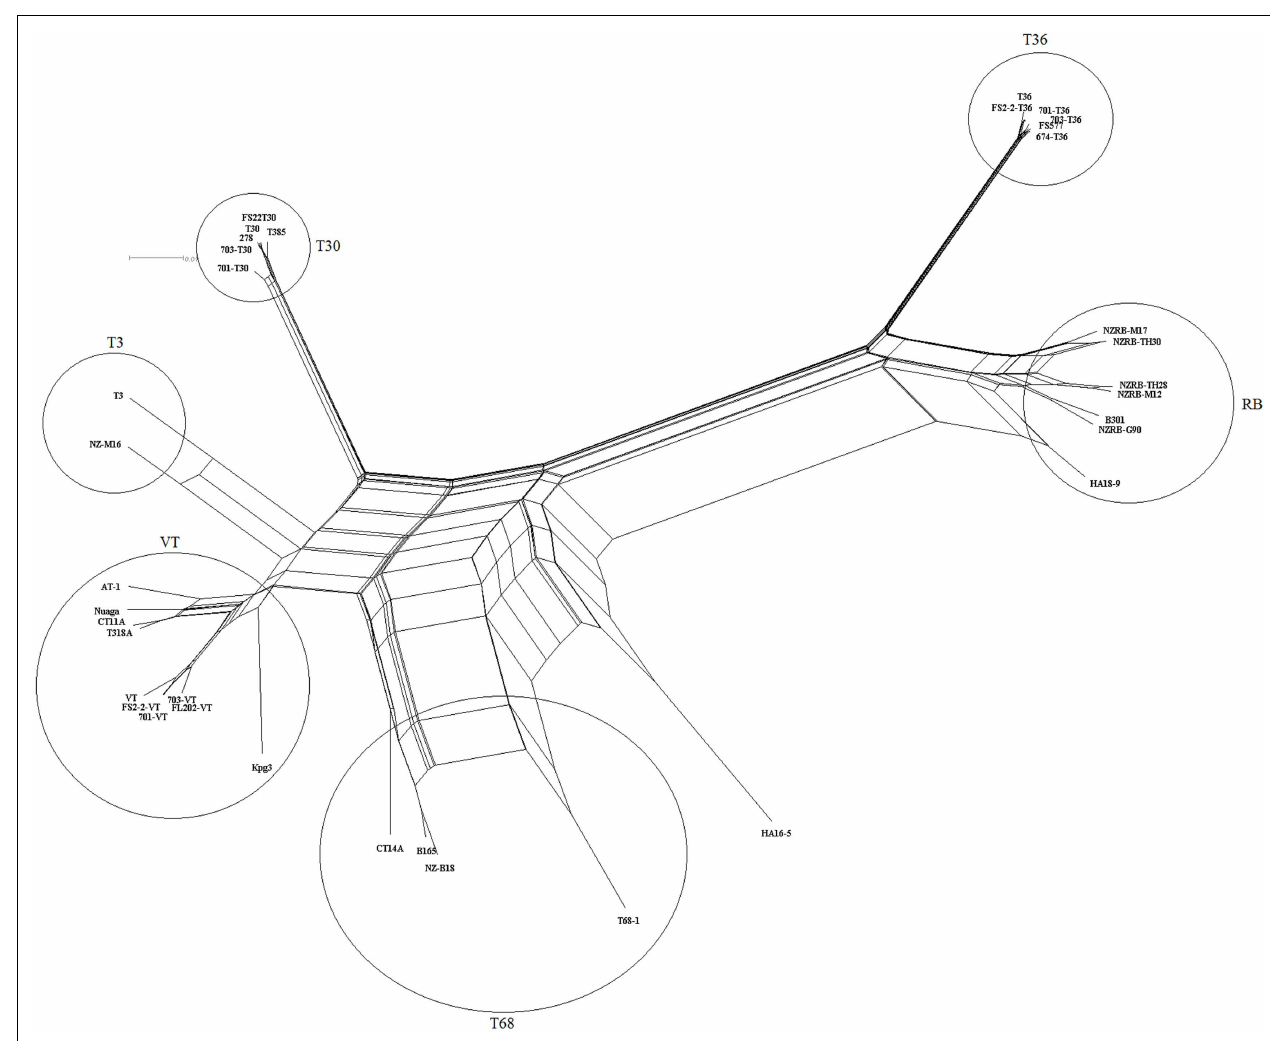
FIGURE 2 | Neighbor network reconstruction of the complete genomes of Citrus tristeza virus examined in this study . Major strains groupings are